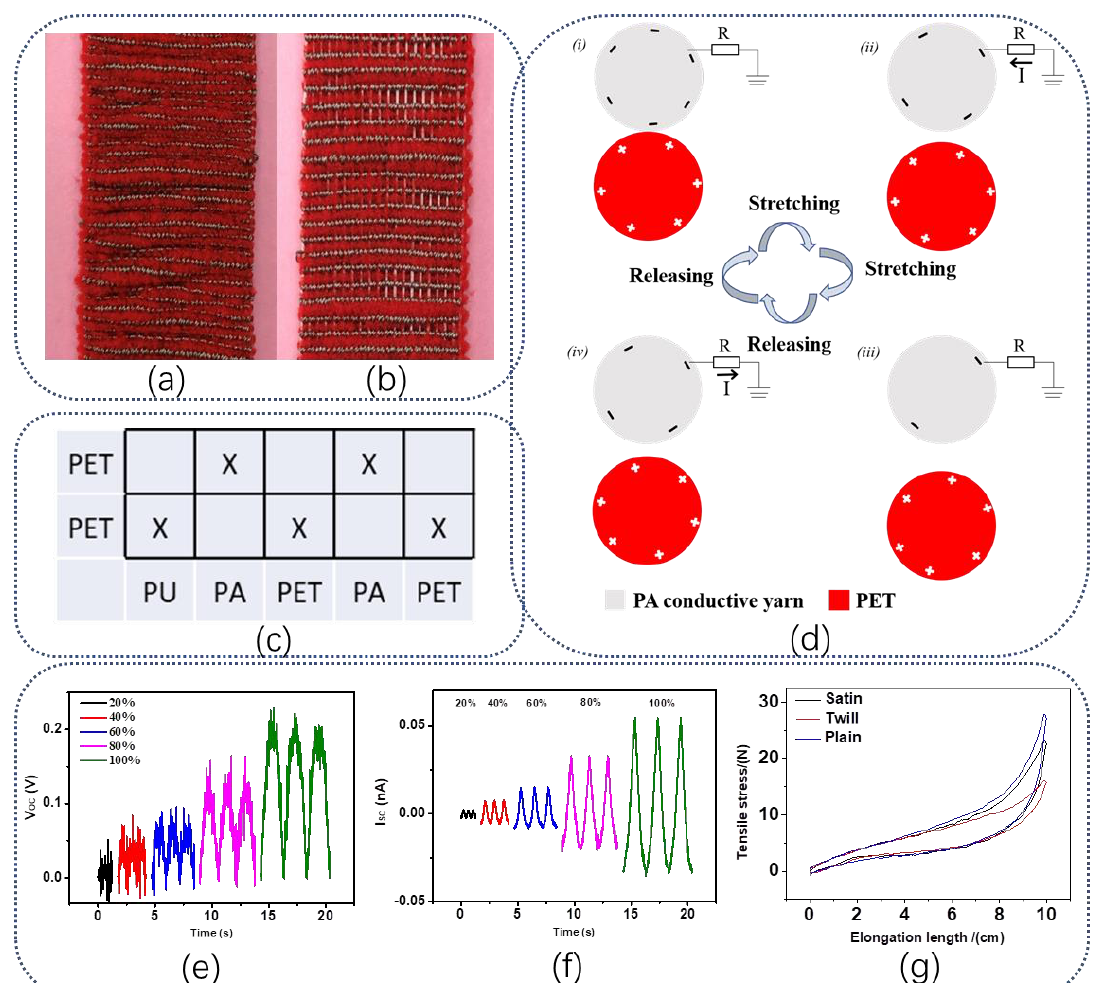
Figure 6. ( a , b ) Digital photographs of SWF − TENG with plain weave before and after stretch; ( c ) The weave diagram of plain structure; ( d ) The working mechanism of SWF − TENG with plain structure, ( i ) The SWF−TENG is stretched at the largest deformation state; ( ii ) The SWF−TENG is gradually recovering; ( iii ) The SWF−TENG recovers to the original state; ( iv ) The SWF−TENG is gradually stretched. ( e , f ) Electrical output performances of SWF − TENG with plain structure; ( g ) The tensile property of the SWF − TENG with different structures.